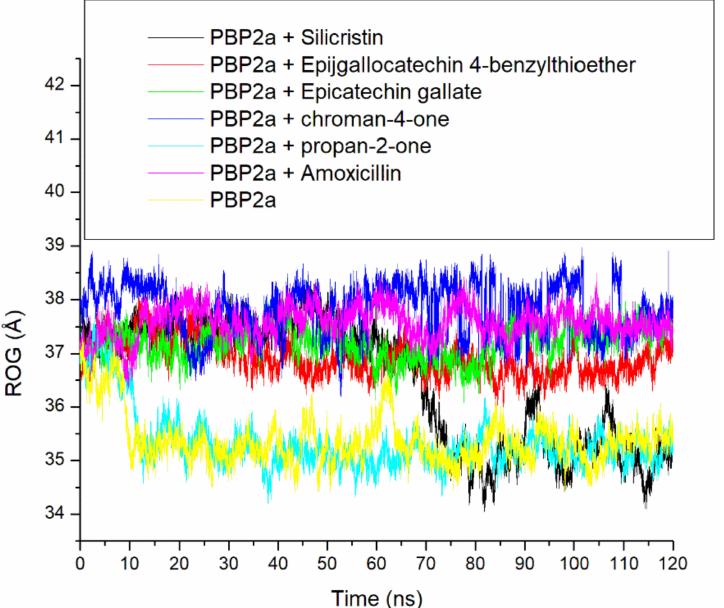
Figure 6. Comparative radius of gyration (ROG) plots of alpha-carbon, the top-five phenolics, and amoxicillin against the active site of PBP2a of S. aureus over a 120 ns MD simulation